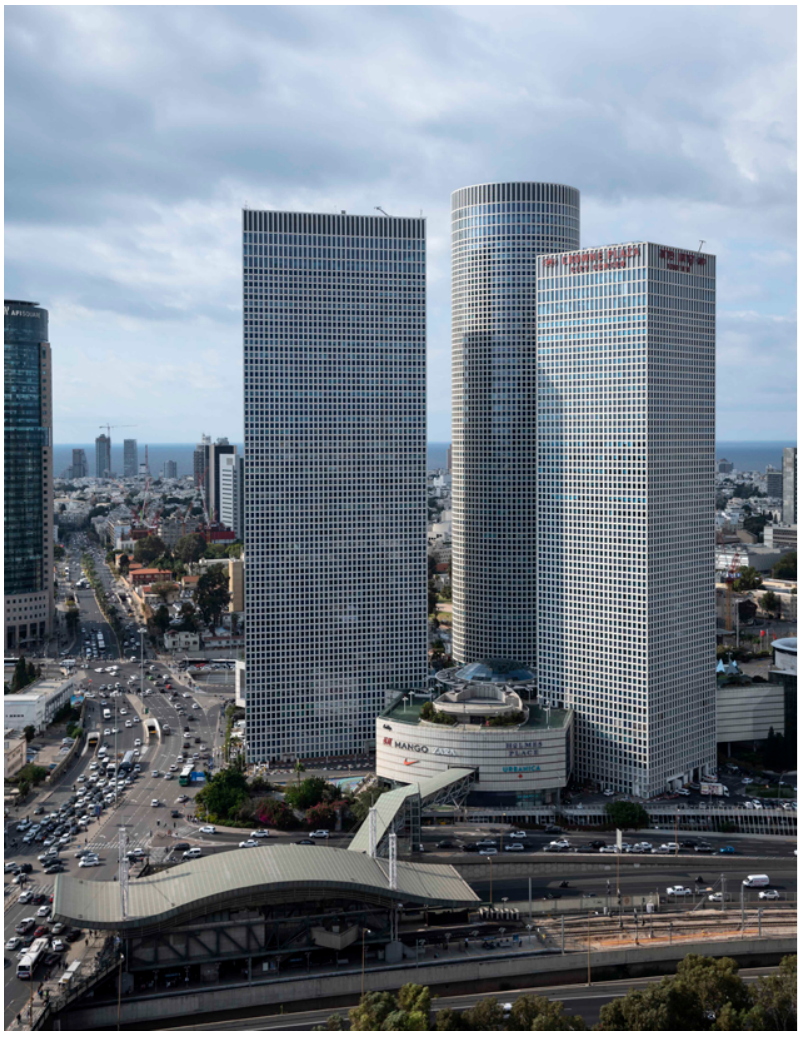
The Azrieli Center and the Shalom junction [credits: Ynhockey, CC BY-SA